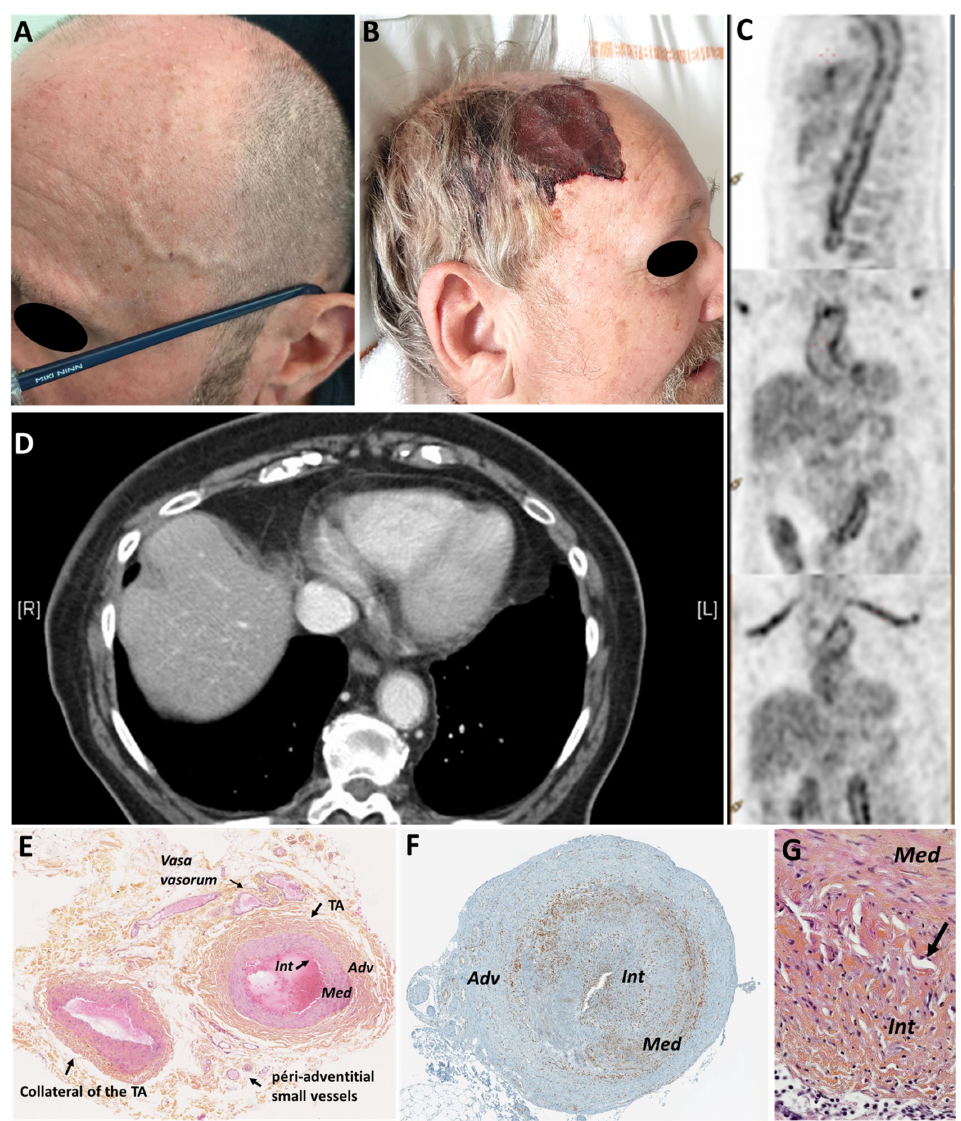
Figure 1. ( A ). Abnormal left temporal artery (enlarged, tender, and without pulse) in a giant cell arteritis (GCA) patient. ( B ): Scalp necrosis in a patient with severe cephalic GCA ( C ): PET-CT showing large vessel involvement (aorta and subclavian arteries) in a GCA patient. ( D ): Angio-CT showing aortitis in a GCA patient. The wall of the aorta is thickened (>2 mm) in a circumferential and homogeneous manner (white arrow). ( E ): Histological sections of a healthy temporal artery biopsy (TAB). The structure of the media is preserved, the intima is thin, the internal elastic lamina is preserved, the wall is not infiltrated by mononuclear cells and the vascular lumen is preserved. Vasa vasorum are seen in the adventitia and small peri-adventitial vessels are observed around the adventitia. A collateral of the TA is also observed; ( F ): Immunohistochemistry showing T-cell labeling (CD3) in a positive TAB of a GCA patient. Marron staining shows typical transmural T-cell infiltrate with a predominance at the adventitia/media junction. The media and the internal elastic lamina are destroyed, the intima is hyperplastic and the vascular lumen is stenosed. ( G ): Fragmentation of the internal elastic lamina (arrow) in a GCA-positive TAB. Adv: adventitia; TA: temporal artery; TAB: temporal artery biopsy; Int: intima; Med: